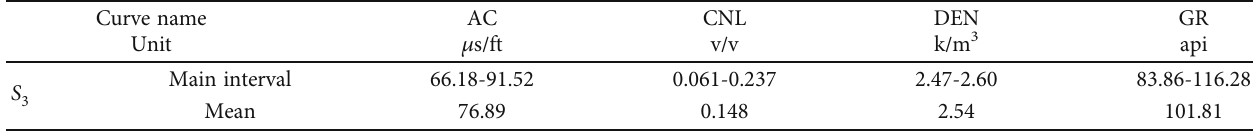
and S of well X2. 2 3 in well 3